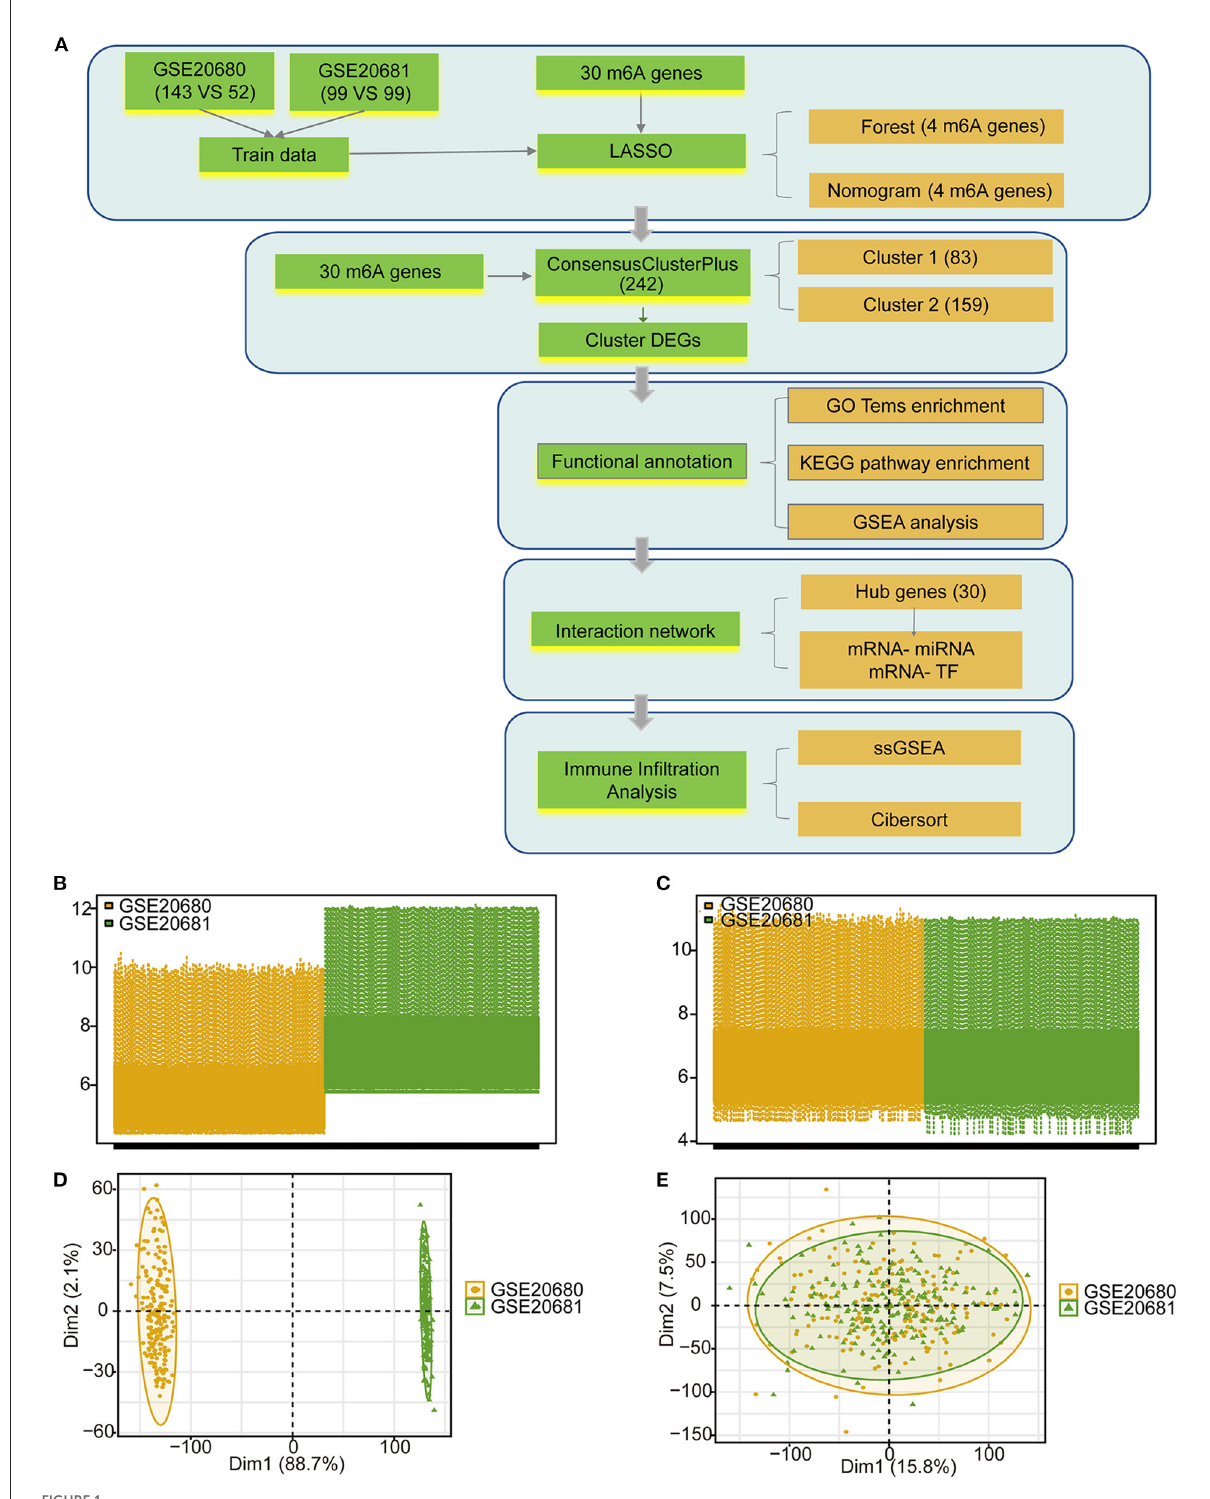
FIGURE1 The data preprocessing and analysis process. (A) The work flow of this study. (B) Box plot showing the two GEO data sets before standardization. (C) Box plot showing the two GEO data sets after standardization. (D) PCA analysis of the two data sets before standardization. (E) PCA analysis of the two data sets after